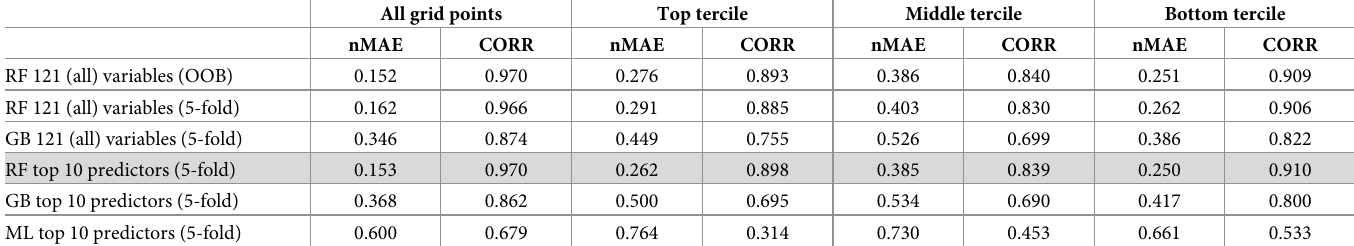
Table 3. Comparison statistics for different number of variables and different models (RF, GB and ML) and for all grid points (first two columns), the top tercile of GCP-PC (third and fourth columns, the middle tercile of GCP-PC (fifth and sixth columns), the bottom tercile of GCP-PC (last two columns). OOB stands for Out- of-bag prediction (a feature of the RF model). The top 10 predictors have been selected using the procedure described in the Methodology section. The row with the top 10 predictors for RF, which is used in the rest of the study, has been highlighted in